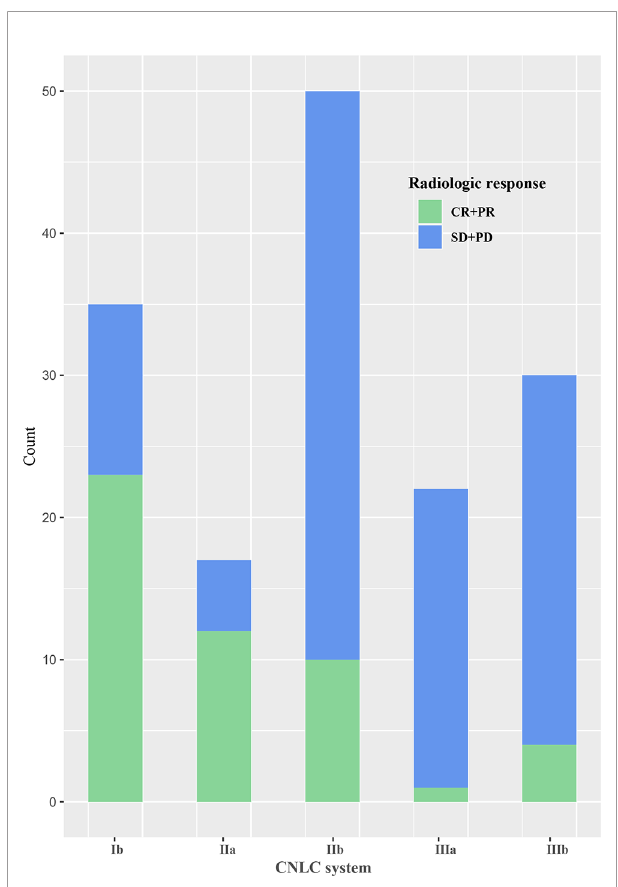
FIGURE 3 | Bar graph of the distribution of radiologic response strati fi ed by the China liver cancer staging (CNLC)